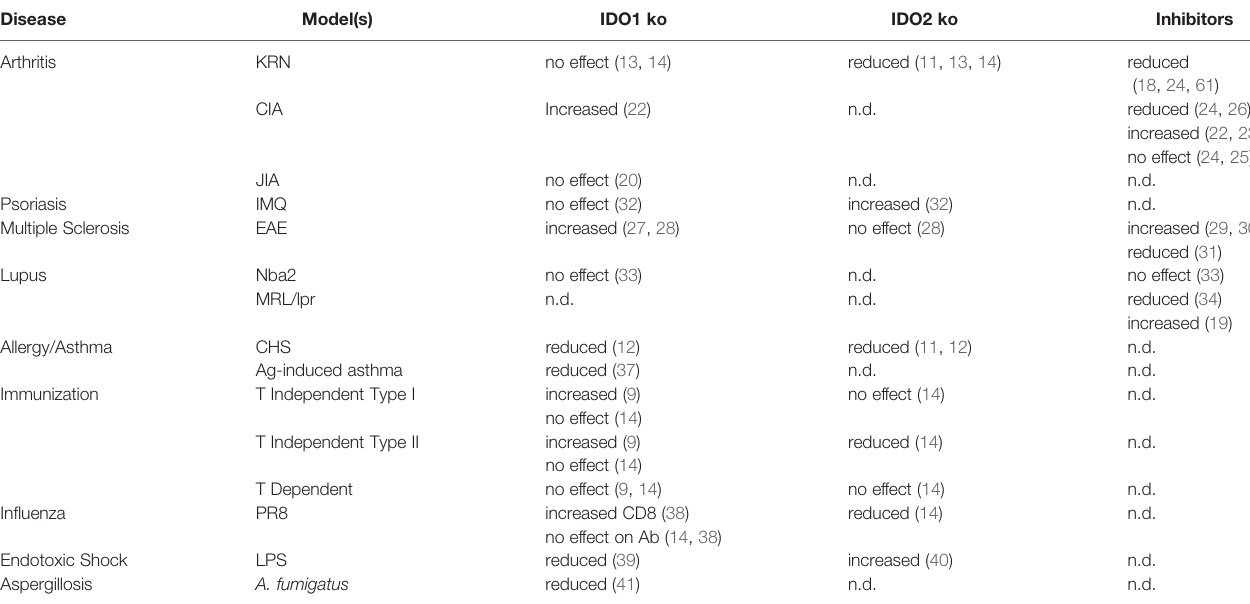
TABLE 1 | Effect of IDO1 and IDO2 on autoimmune and in fl ammatory disease.